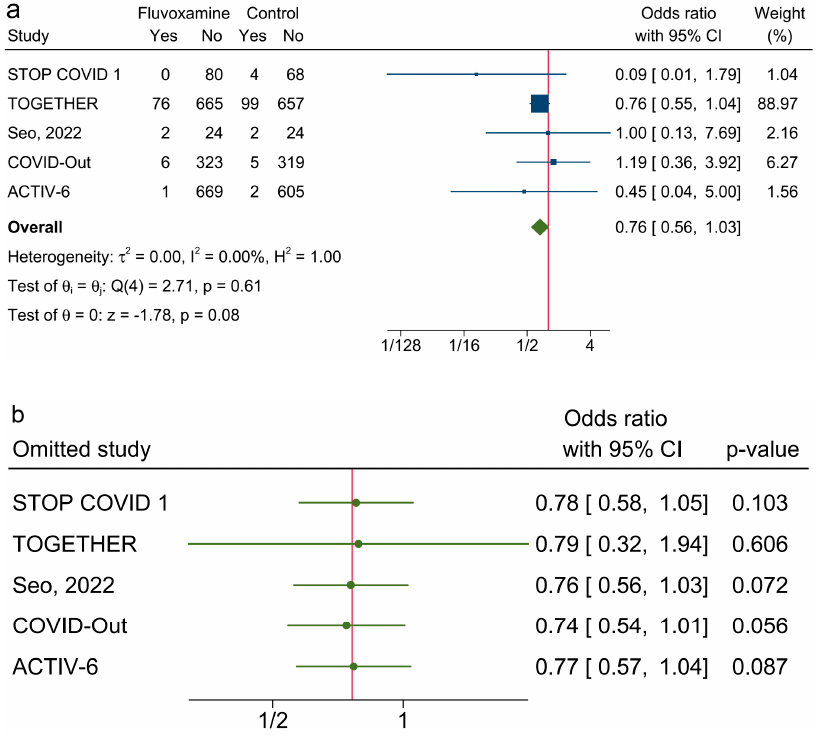
Figure 4. ( a ). Forest plot of random-effects meta-analysis of hospitalization. ([7,8,16–18]) ( b ). The leave-one-out test for the secondary outcome.